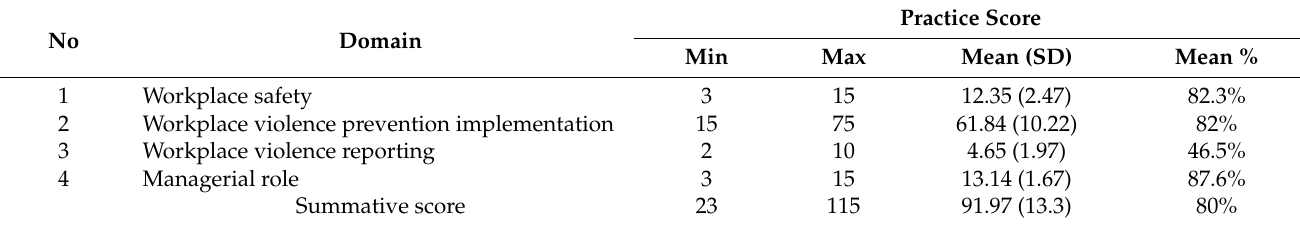
Table 3. Mean percentage of practice towards WPV prevention domain in PPWVP ( n = 162).